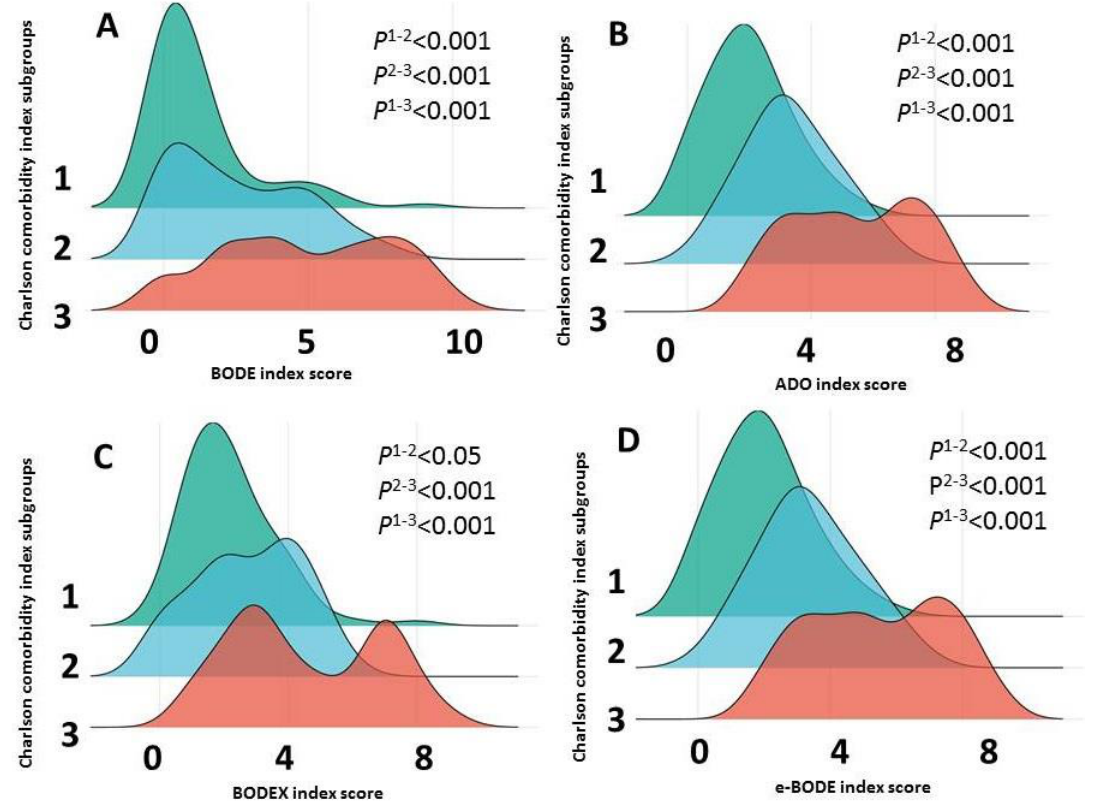
Figure 9. Plot of BODE (A), ADO (B), BODEX (C) and e-BODE (D) as a function of the severity of comorbid disease, as assessed by the Charlson Comorbidity Index and classified into 3 subgroups. Note: Statistical significance of differences in BODE, ADO, BODEX, and e-BODE index values in patients divided into three subgroups according to Charlson Comorbidity Index values are shown.